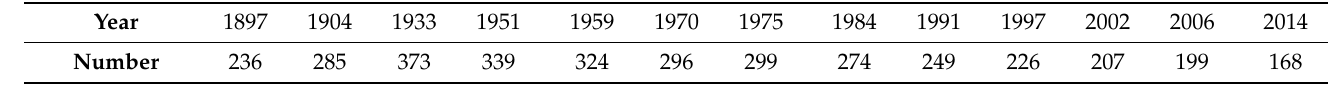
Table 6. Open Brethren assembles,